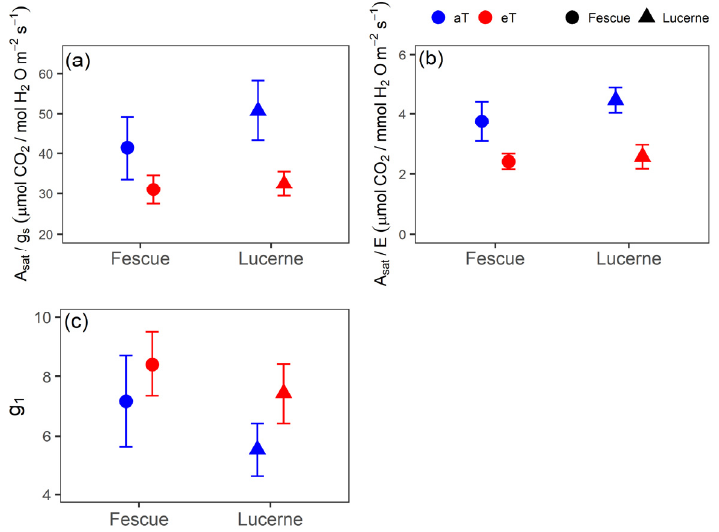
Figure 5. Water use efficiency parameters for tall fescue (circles) and lucerne (triangles) grown under 26 ◦ C (aT, blue) and 30 ◦ C (eT, red). ( a ) Ratio of light-saturated photosynthesis at ambient [CO 2 ] (A sat ) to stomatal conductance (g s ) (WUE i ), ( b ) Ratio of A sat to transpiration ( E ) (WUE inst ), ( c ) model fit parameter using Equation (1) (g 1 ). Values shown are means and error bars indicate ± standard error ( n =